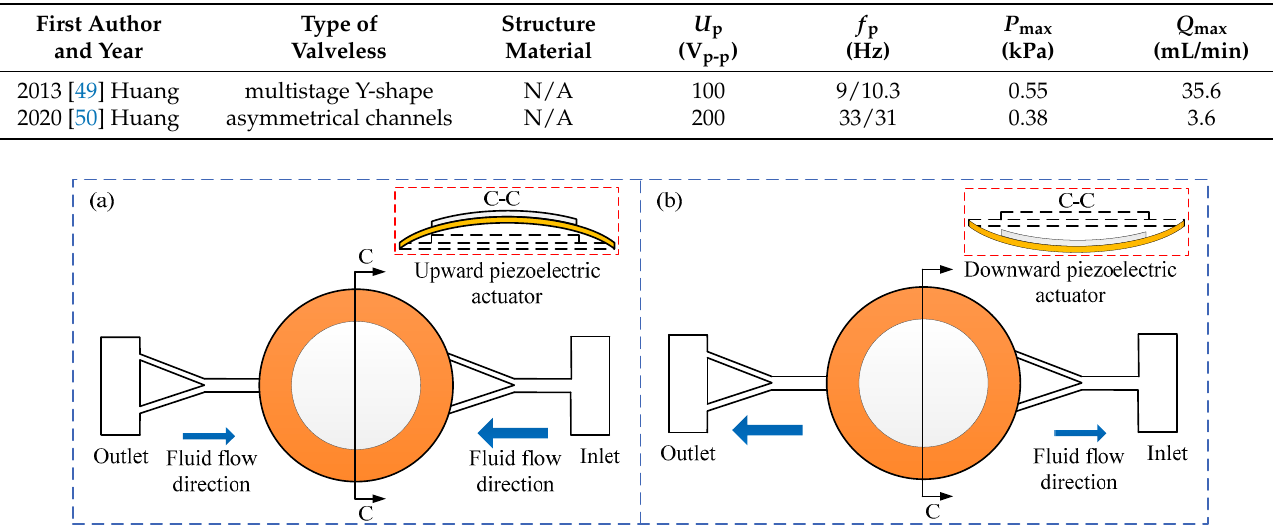
Table 2. Summary of properties for the valveless piezoelectric pump with Y-shape tubes.